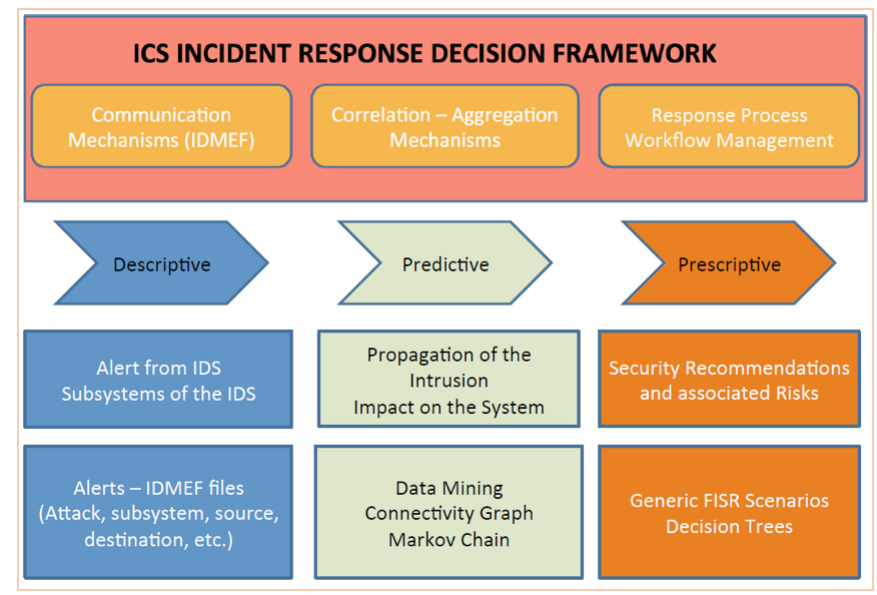
Figure 7. Incident-response decision framework